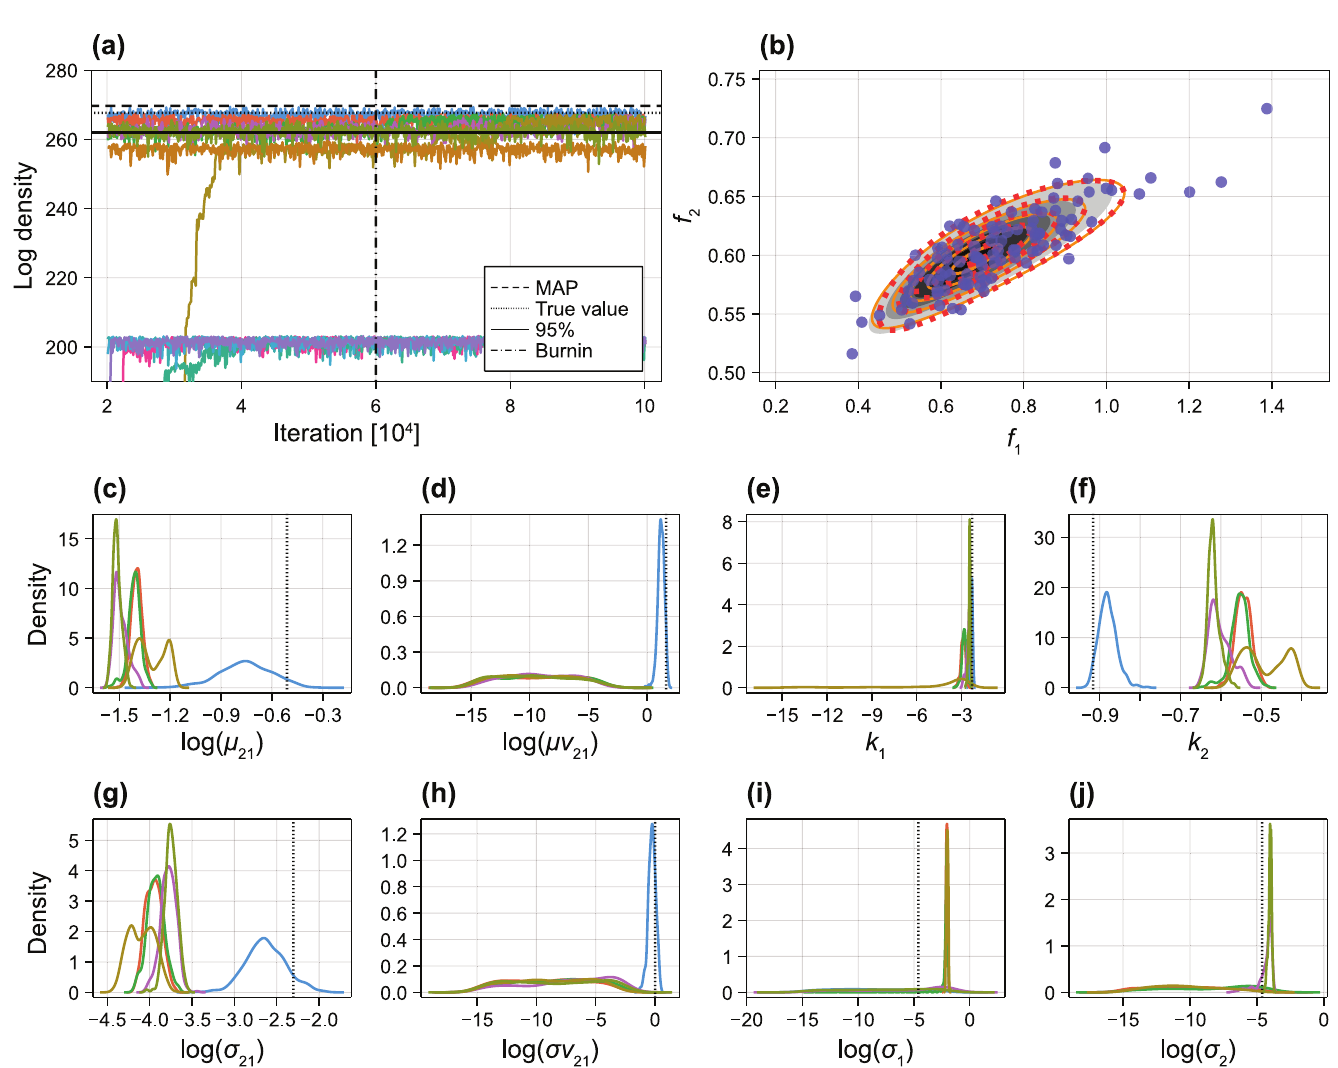
Fig 9. MCMC results for non-linear two-pool model. (A) MCMC was run for 10 5 iterations at twelve initial locations: eleven sampled from the prior and one at the true value. Coloured curves show convergence in the log posterior density. Also shown is the posterior density at the MAP (dashed), posterior density at the true value (dotted), a 95% threshold based on an asymptotic chi-squared distribution and the MAP (solid). The first 6 × 10 4 iterations were discarded as burn-in. Each colour corresponds to an independent MCMC chain. (B) Synthetic data (discs), approximate model solution at the MAP (orange solid), approximate model solution at a model where V 21 has zero variance (red dotted), and approximate model solution at the true values (grey). (C–F) Marginal posterior densities for each parameter. Each colour corresponds to an independent MCMC chain.